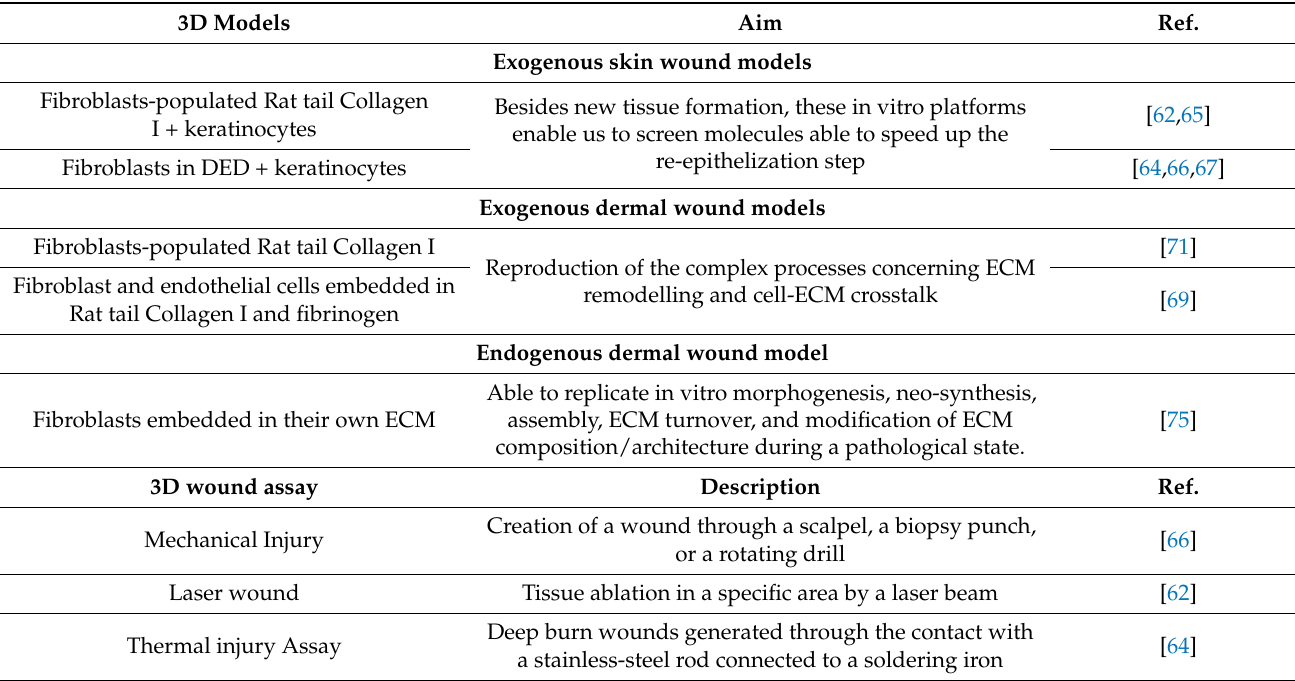
Table 3. Common 3D models used for tridimensional wound healing